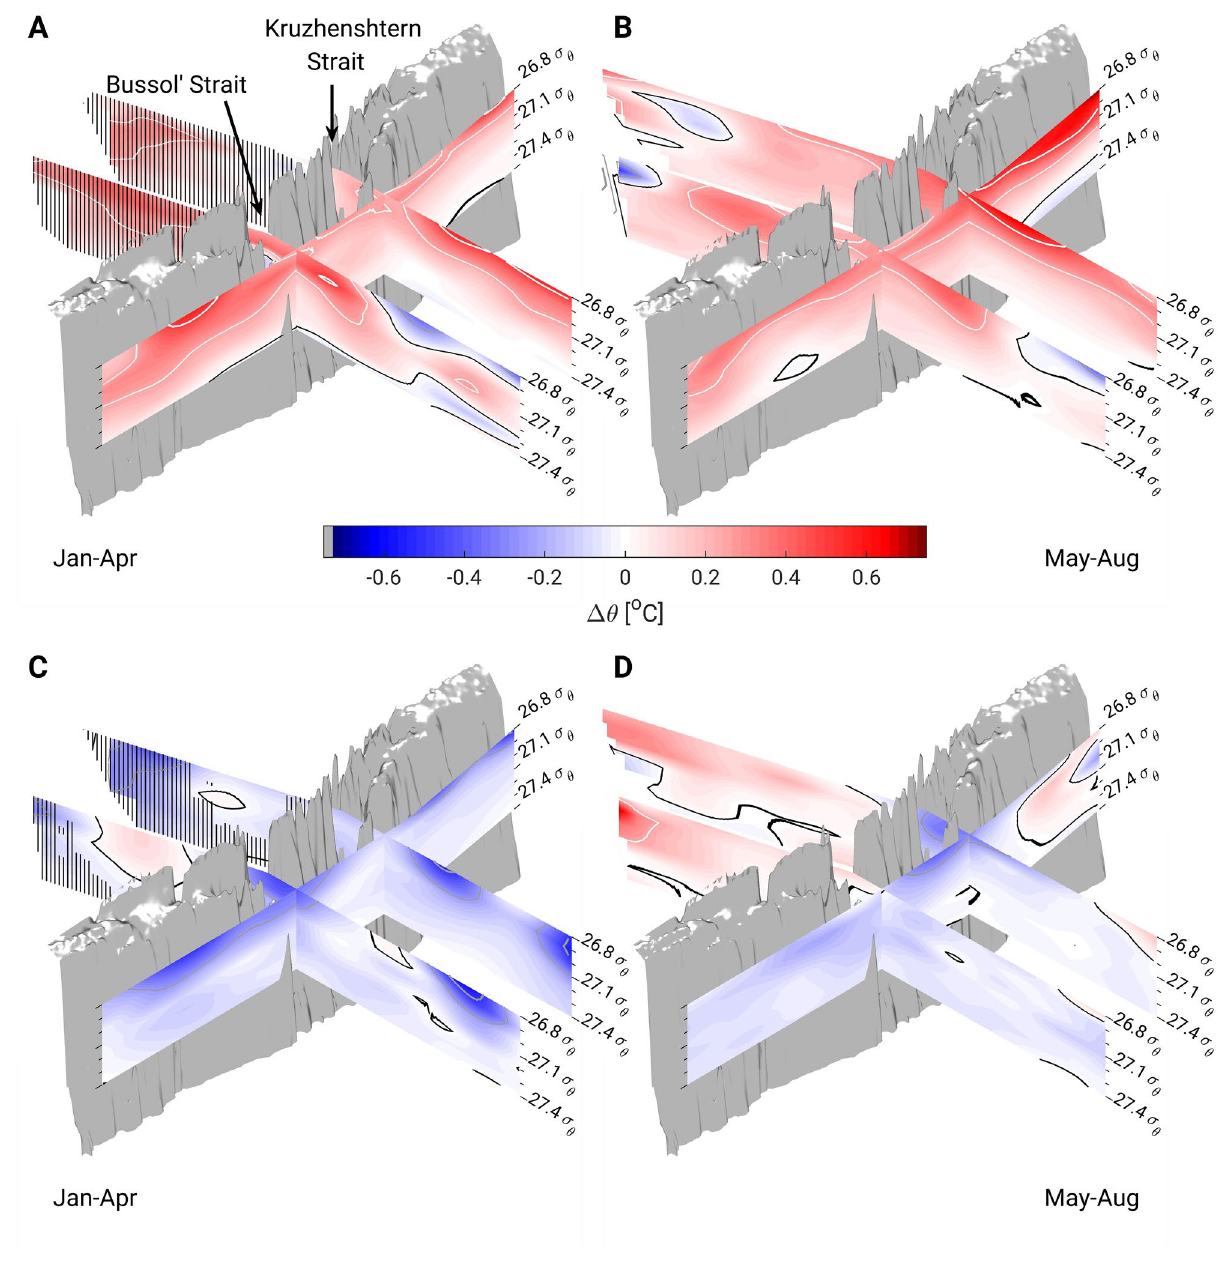
Figure 4. Cross-section of long-term trend and bidecadal (18.6-year tide) temperature anomalies on a σ θ - grid in the northern Pacific and the Sea of Okhotsk. From ( A ) January to April and ( B ) May to August. The anomalies every + 0.25 °C (− 0.25 °C) are represented by thin solid white (grey) lines and every + 0.5 °C (− 0.5 °C) by thick solid white (grey) lines. The thin solid black line represents the limit of the 0 °C anomaly. Barred vertical lines represent areas where values were calculated with 10–30 raw data points. ( C , D ) Same as ( A , B ) but for the 18.6-year tidal cycle, for which the temperature difference between strong tide years and weak tide years is calculated. To better reveal large-scale patterns, data along each section were smoothed with a 100-km half- width moving average filter. For non-smoothed data, the reader is referred to the map of temperature differences at 26.9 σ θ in Fig.